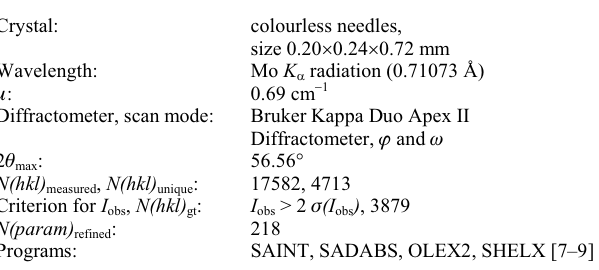
Table 1. Data collection and